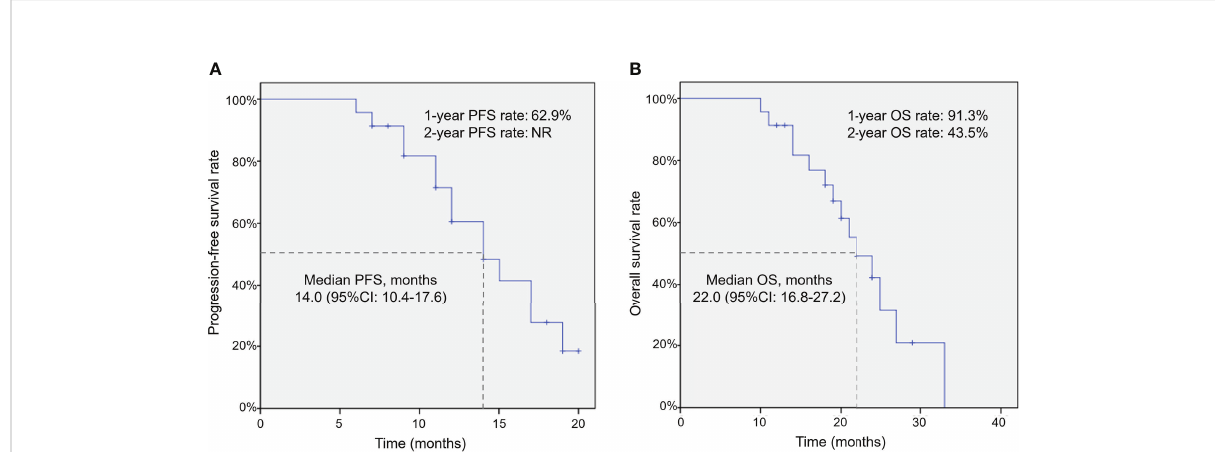
FIGURE 1 Survival of patients with liver metastases from NSCLC after integrated interventional therapy. PFS (A) and OS (B) among patients after integrated interventional therapy of CSM-TACE combined with 125 I brachytherapy. PFS, progression-free survival; OS, overall survival; NSCLC, non – small ‐ cell lung cancer; CSM-TACE, CalliSpheres ® microsphere transarterial chemoembolization; CI, con fi dence